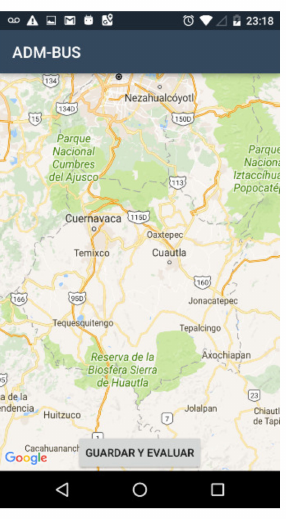
Figure 13. Graphical interface for maps.